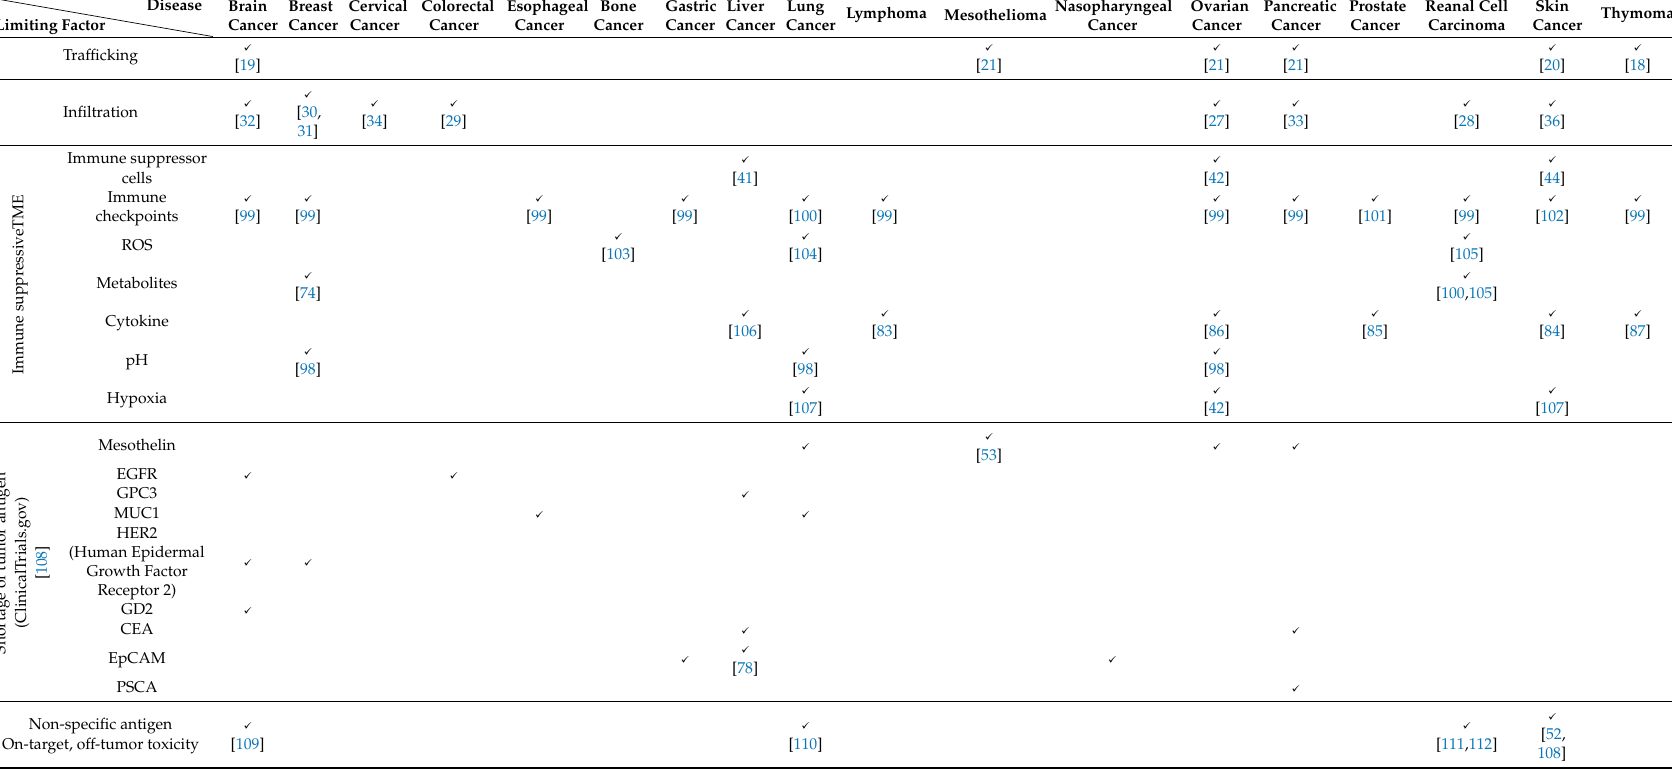
Table 1. Limiting factors for chimeric antigen receptor T (CAR-T) cell function in various cancer types.